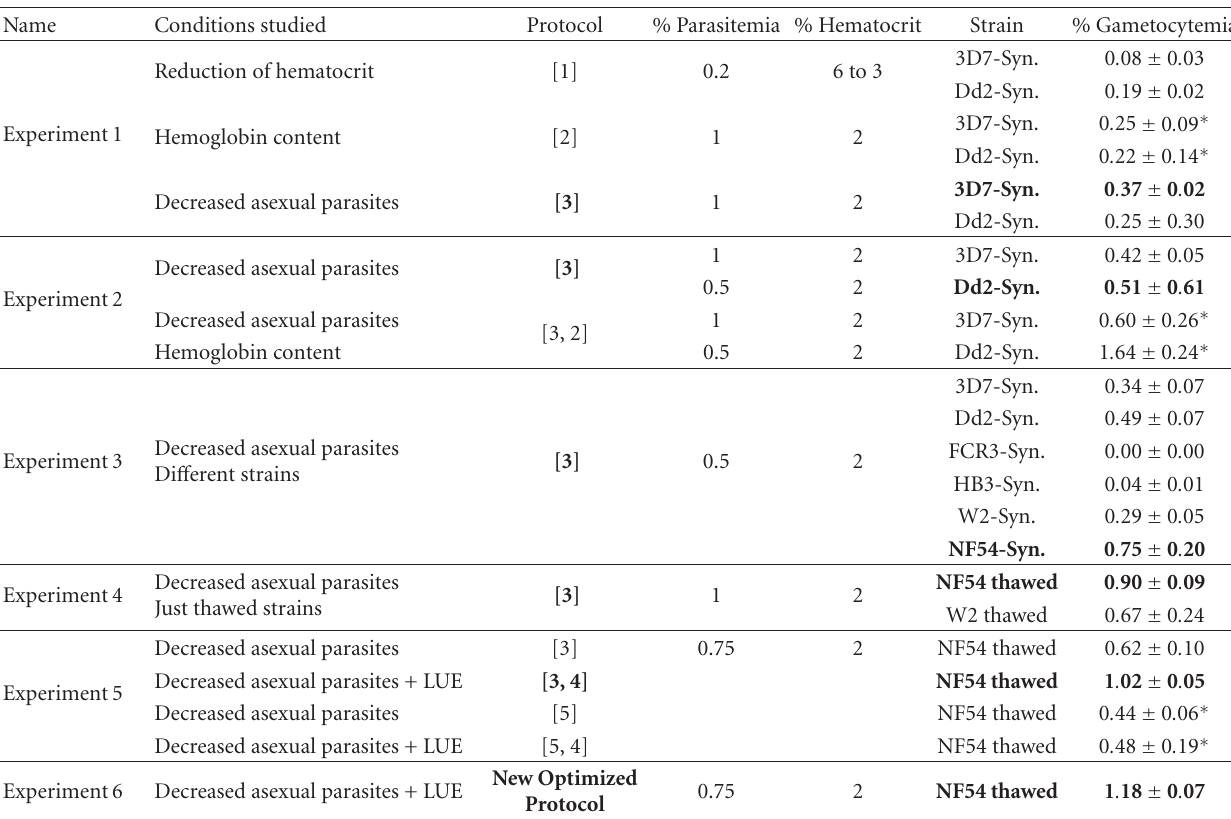
Table 1: Factors involved in gametocytogenesis studied and corresponding gametocyte